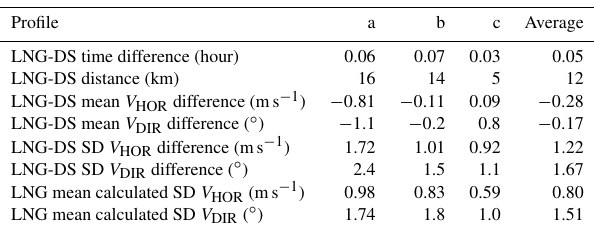
Table C1. Summary of mean differences between wind lidar and ra- diosonde profiles a, b, c, as given in Fig. C2, and related and related standard deviations (SDs).